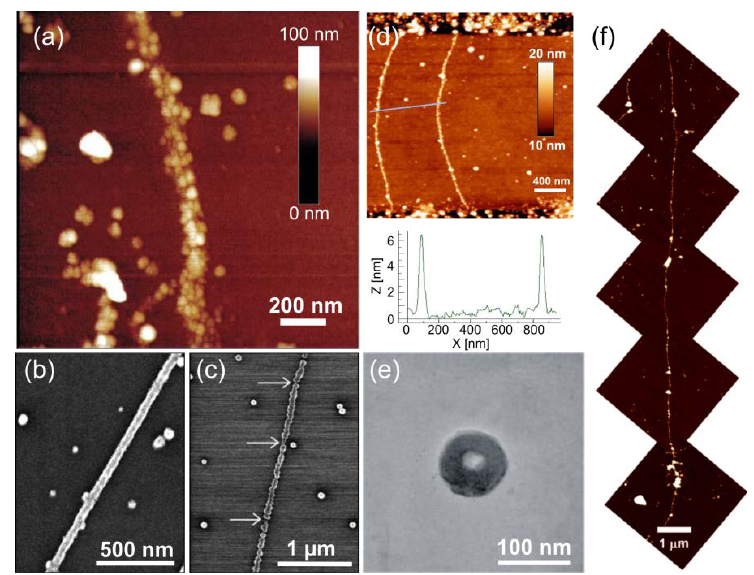
Figure 1. ( a ) Atomic force microscope (AFM) image of silver nanowires [65]; ( b ) continuous Pd